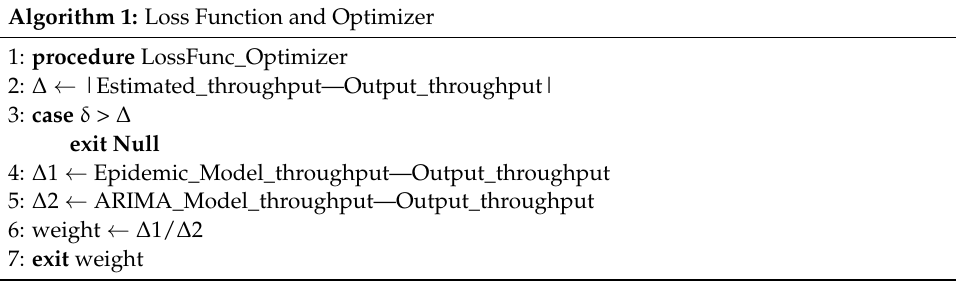
Algorithm 1: Loss Function and